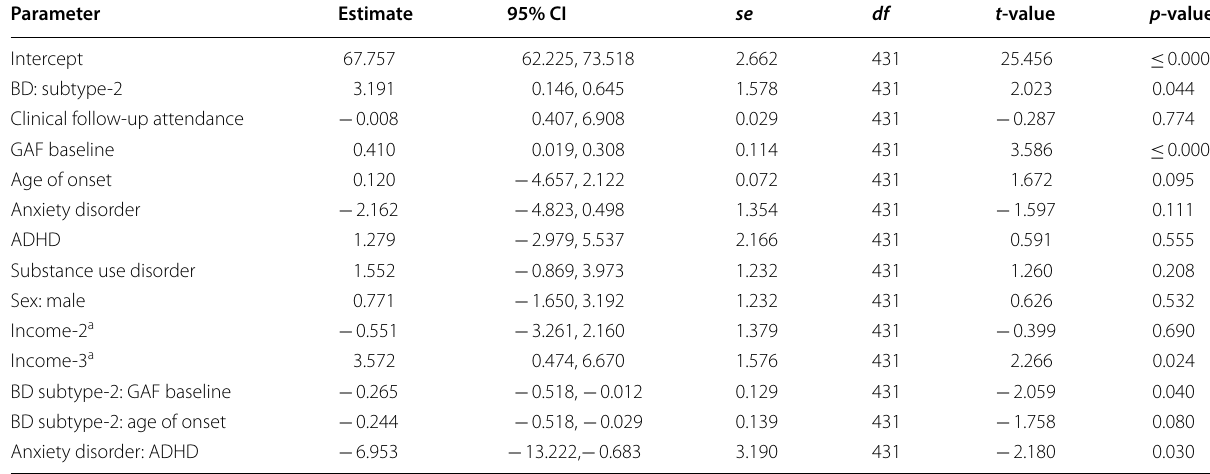
Table 4 Mean GAF score at follow-up (intercept) and change with respect to explanatory